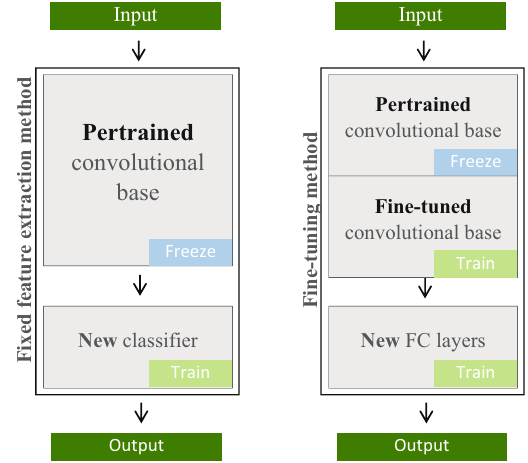
Figure 1: Strategies of transfer learning [ 112 ]